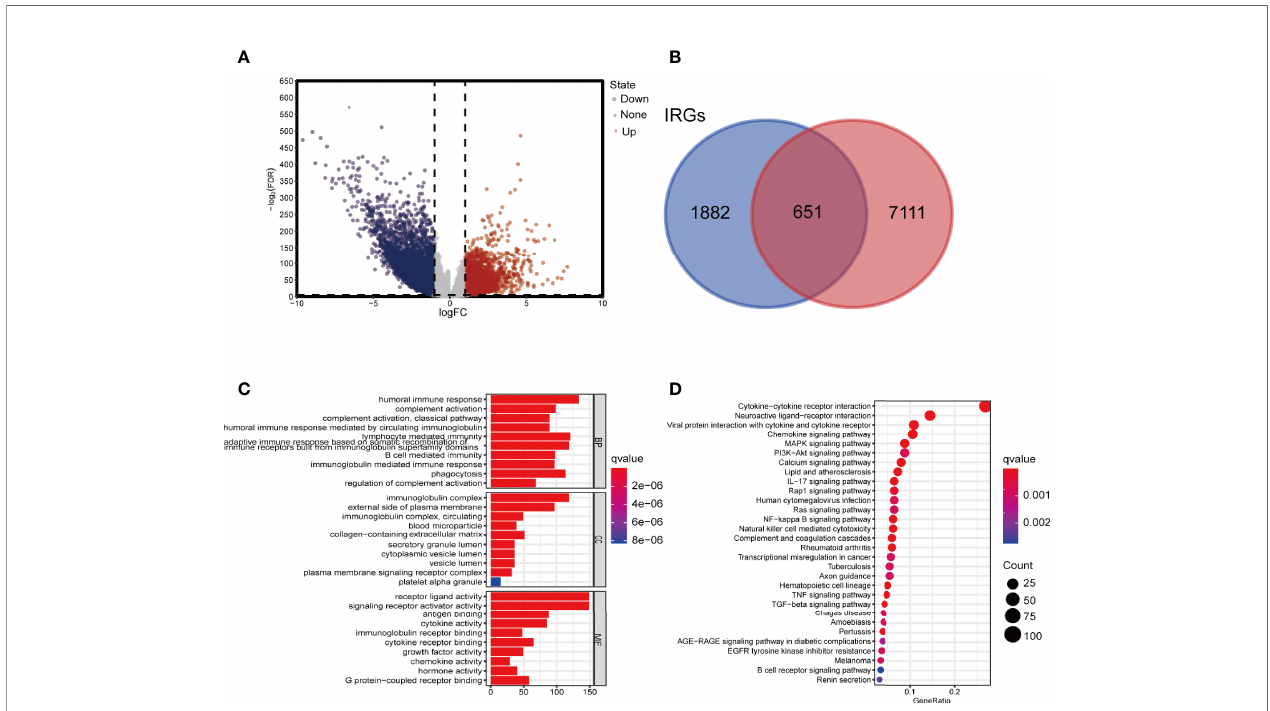
FIGURE 2 | Screening for DEGs and enrichment analysis. (A) Volcano map of DEIRGs. (B) Venn diagram showing the intersection of DEGs and IRGs. (C) GO enrichment analysis of DEIRGs for BP, CC, and MF, respectively. (D) KEGG enrichment analysis of DEIRGs. DEGs, differentially expressed genes; DEIRGs, differentially expressed immune-related genes; IRGs, immune-related genes; GO, Gene Ontology; BP, biological process; CC, cellular component; MF, molecular function; KEGG, Kyoto Encyclopedia of Genes and